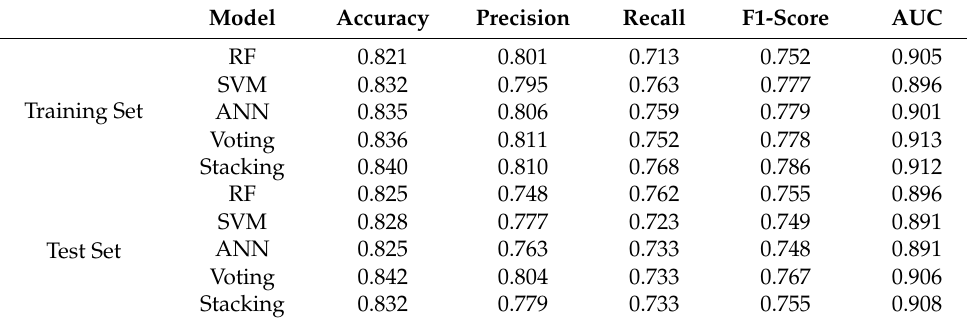
Table 1. Performance metrics of the JNK1 models on training and test sets.